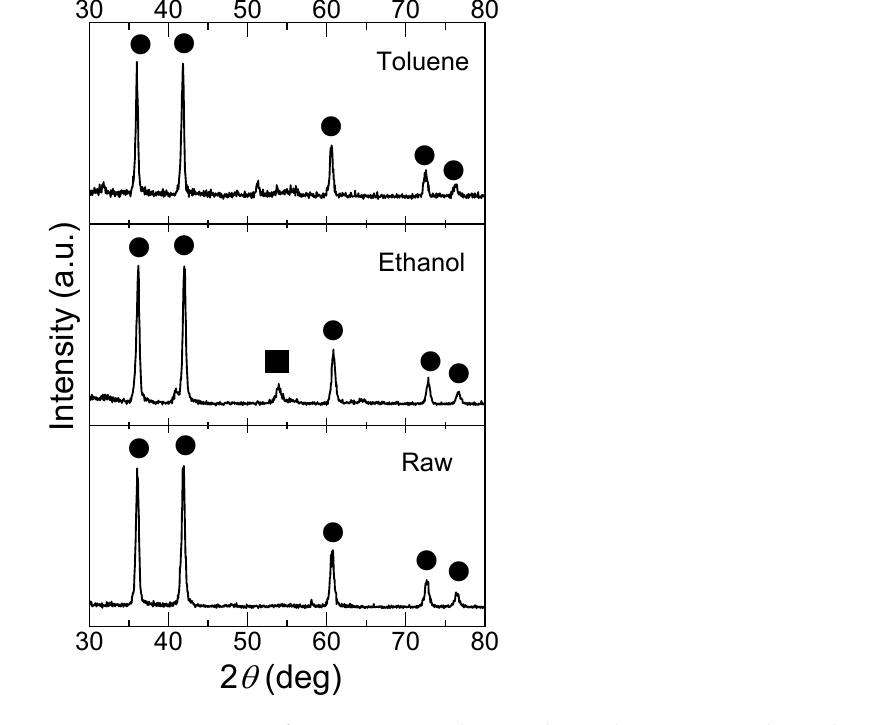
Figure 2. XRD patterns of raw TiC NPs and SMPs obtained via 532 nm Nd:YAG laser irradiation in ethanol and toluene. Circles indicate the TiC peaks, and the square indicates the TiO 2 rutile phase.